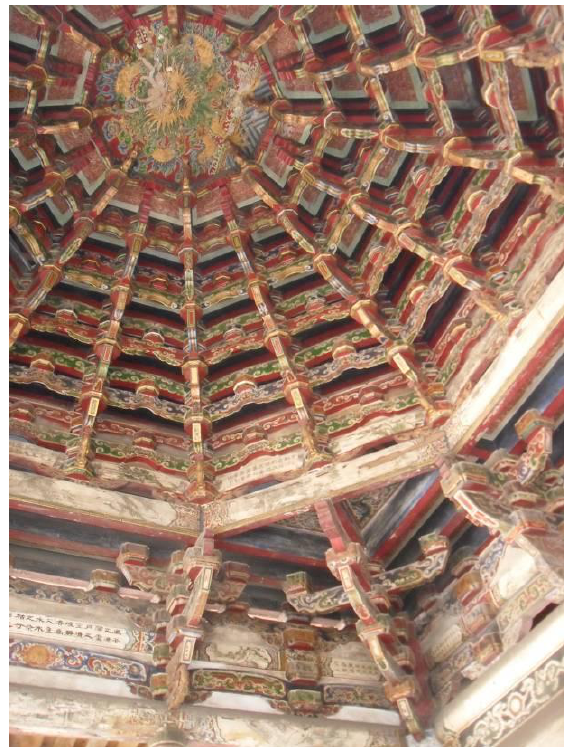
Figure 2. Caisson on the top of stage of Lukang Long Shan